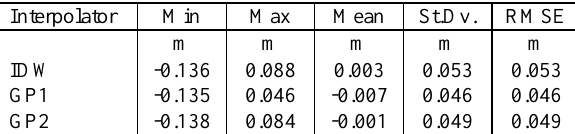
Table 2. Statistical values of the residuals obtained in 20 CPs in the case of GUMs based on 20 GNPs.